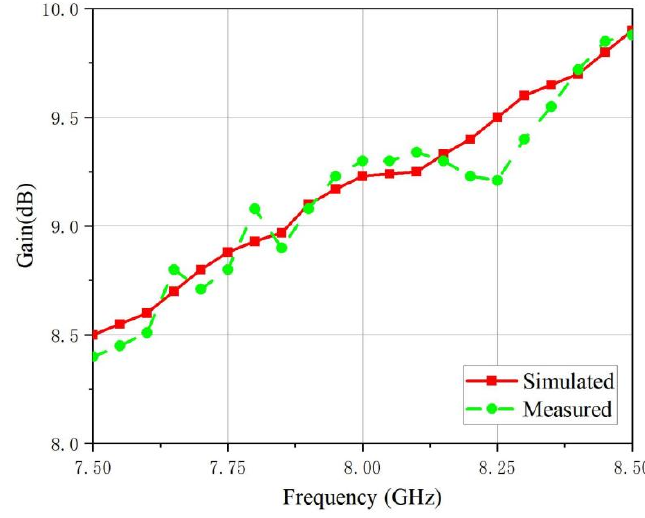
Figure 14. The simulated and measured gain of the HPM unit.